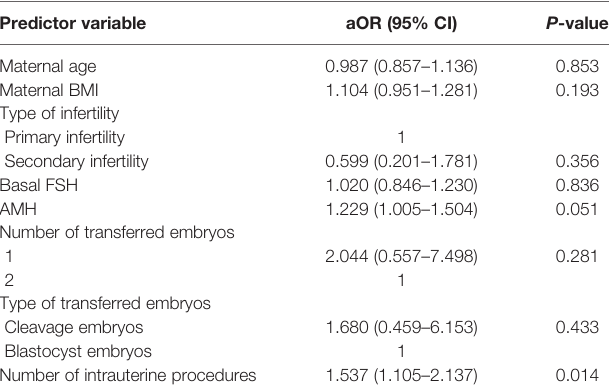
TABLE 3 | Adjusted odds ratios of premature rupture of the membranes by multivariate analysis of predictor variables in RIF patients. Predictor variable